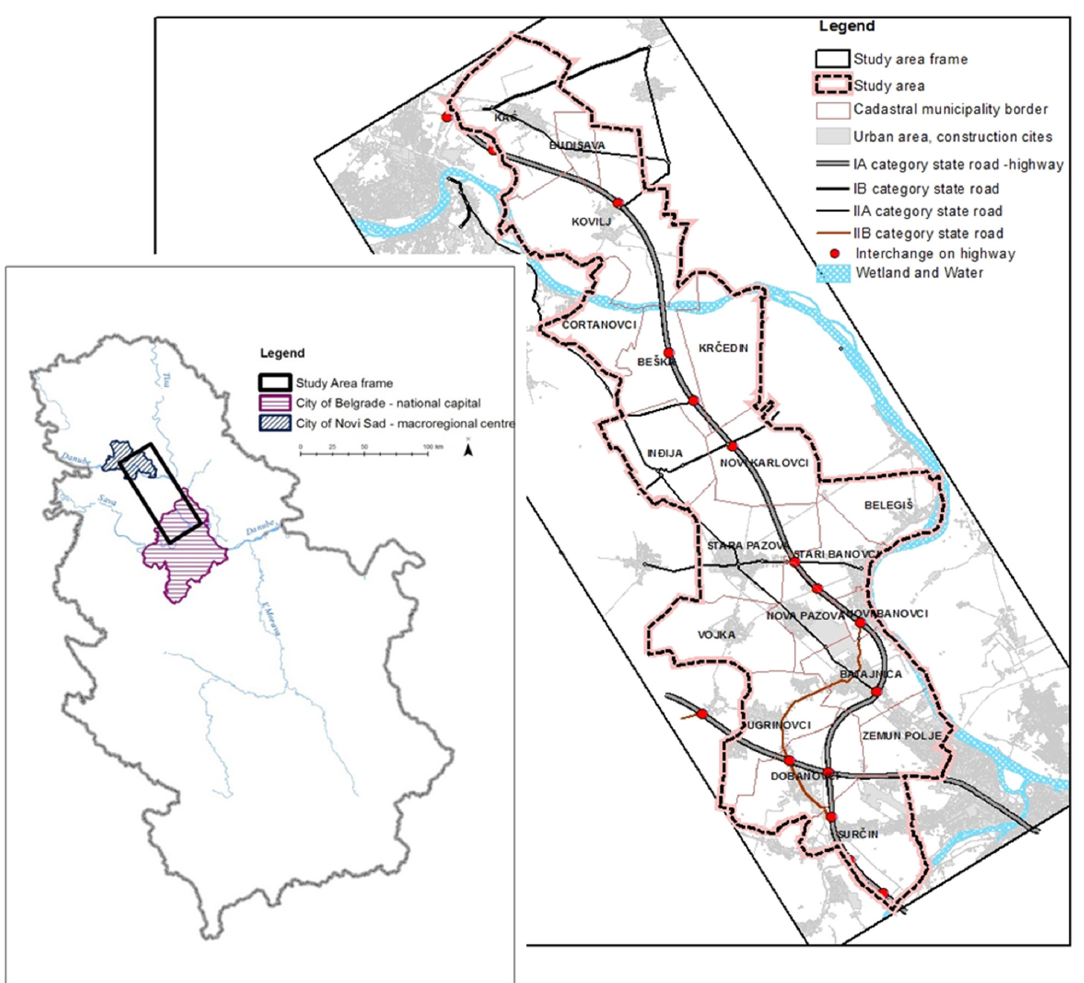
Figure 1. The position of the study area in Serbia, Belgrade–Novi Sad Highway Corridor.